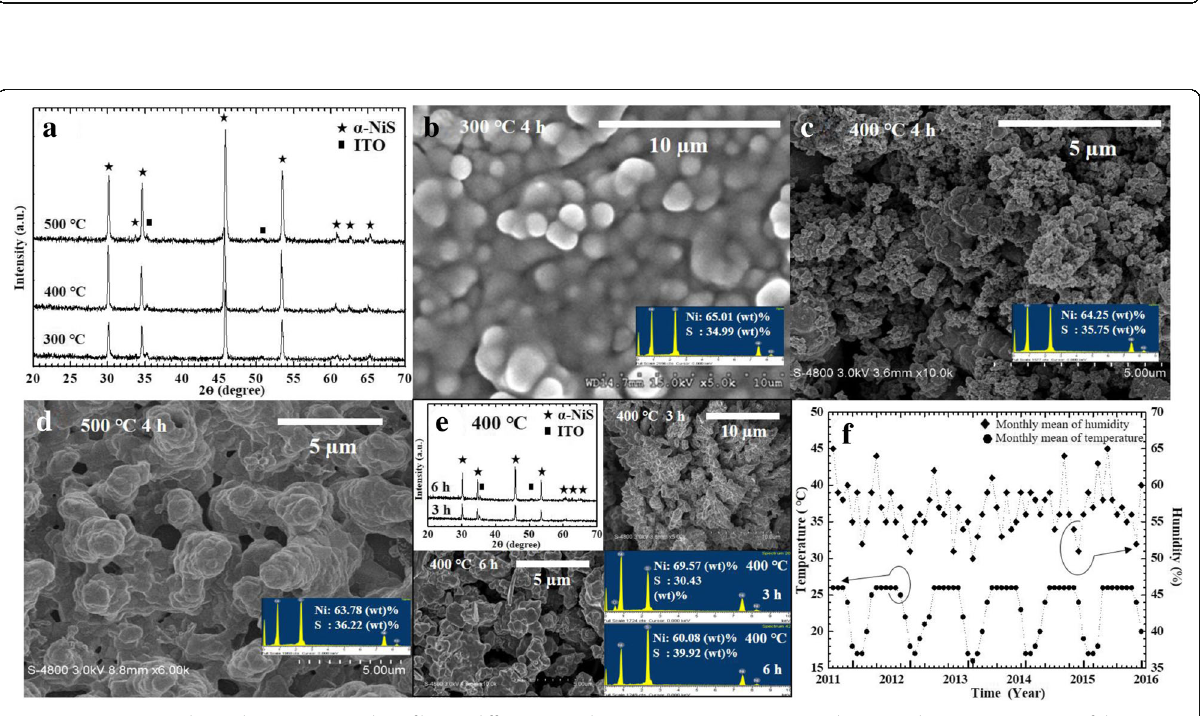
Fig. 1 FE-SEM images of the nickel films. a , b Top view of the nickel nanosheet film was electrodeposited at 3.0 V DC. Inset: cross-section of the nickel nanosheet film. c Top view of the nickel film was electrodeposited at 4.0 V DC. d The XRD patterns of nickel films were electrodeposited at various potentials (3.0 and 4.0 V